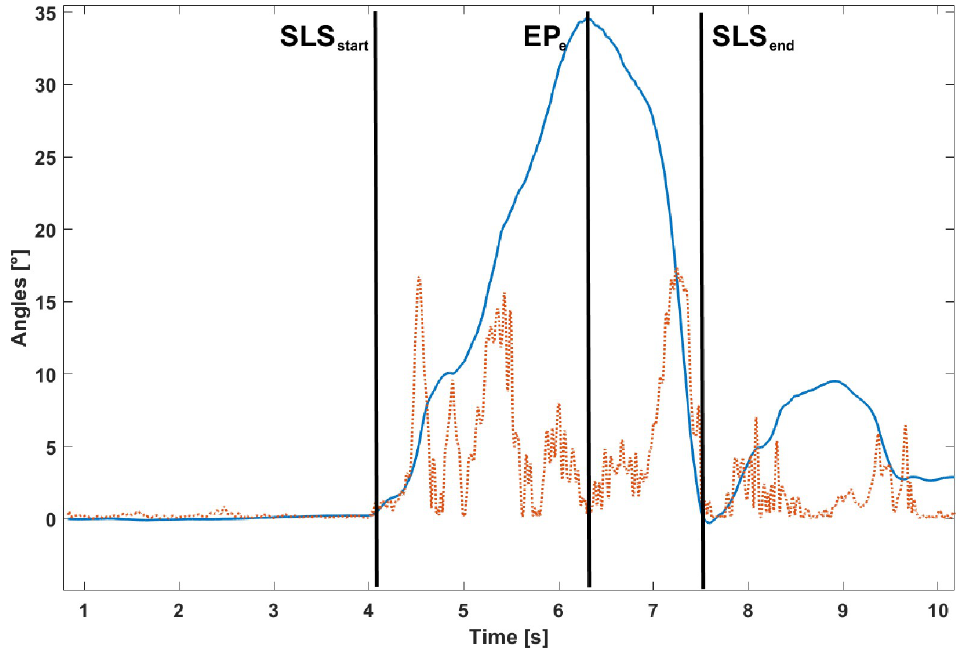
Fig 3. Angular displacement around the Y axis of the tibia MIMU (solid line) and its moving standard deviation of 10-sample window (dotted line). The three instants of time identified for SLS phase segmentation (SLS start , EP e , SLS end ) are also depicted as vertical black